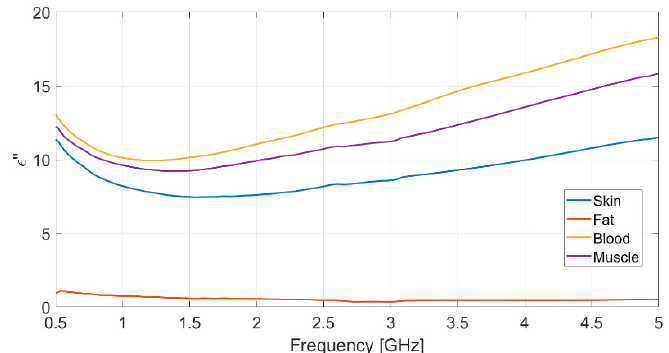
Figure 2. Measured real part of the relative permittivity vs. frequency for each realized bio-phantom.